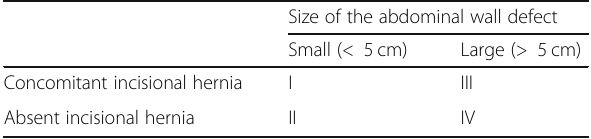
Table 1 Clinical classification of parastomal hernias by the European Hernia Society (EHS). Additionally, parastomal hernias are categorised as either primary (P) or recurrent